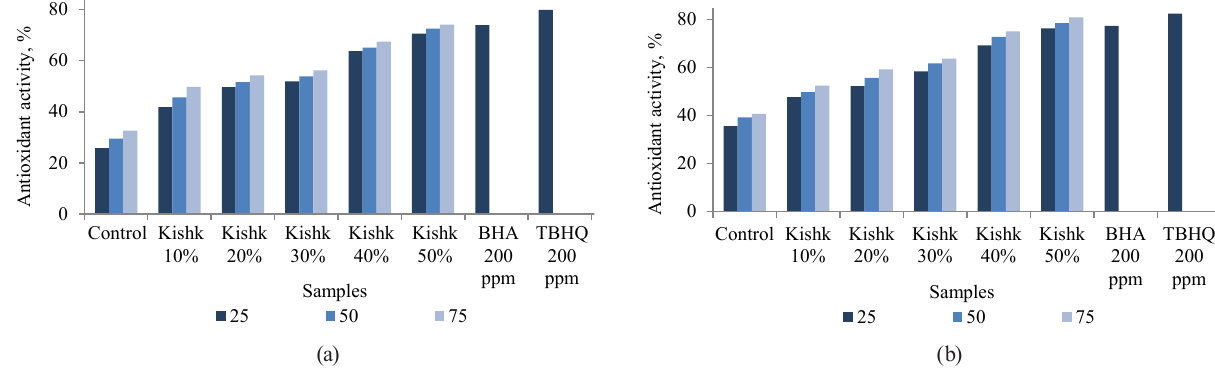
Figure 1 Antioxidant activity of biscuit fortified with Egyptian kishk determined by using DPPH (a) and ABST (b) assays. The same letters are not significant ( P ≤